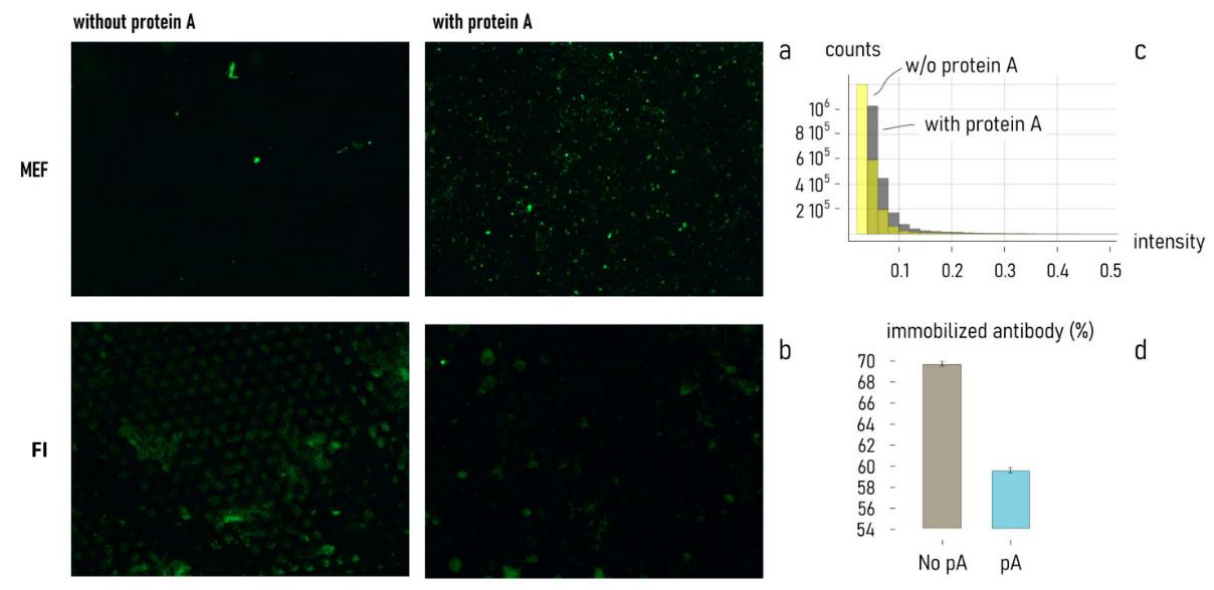
Figure 8. Fluorescence recorded without protA, and therefore with anti-tubulin randomly immobilized binding fluorescent tubulin ( a left), compared to the surface with protA orienting anti-tubulin binding ( a right). The images recorded show an increase in fluorescence recorded of 59% in the surface with the presence of protA. Fluorescent IgG randomly immobilized ( b left) compared to fluorescent IgG bound by protA, higher fluorescence recorded when IgG is randomly immobilized, resulting in higher concentration immobilized. Graph ( c ) show the counts of fluorescent points in relation to their intensity for the a line images. The percentage of immobilized IgG is showed on Graph ( d ) where the immobilized antibody was calculated by an FI test on the solution used for antibody immobilization.